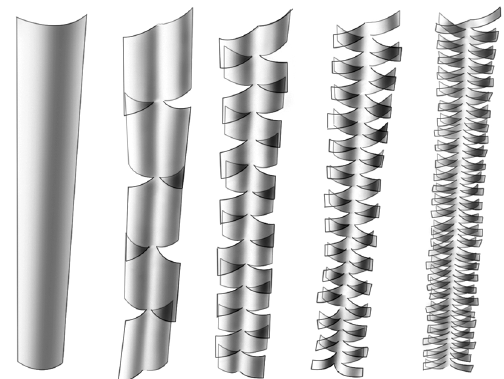
Figure 2. Schematic example of artificial structures built for aquatic invertebrate colonization. Artificial structures permit variation in complexity without altering superficial area or exposed time to attached organism’s colonization, in addition to avoiding biological plant characteristics, such as differences in leaf roughness, chemical quality or allelopathic substances. Note that by being described by a scaling law, the increase in complexity with fractal dimension is not linear (small increases in D results in great increases in complexity, especially at larger num- bers, e.g., close to 2.0). Approximate fractal dimensions (from left to right): 1.1, 1.2, 1.3, 1.4 and 1.6. Based on Mormul